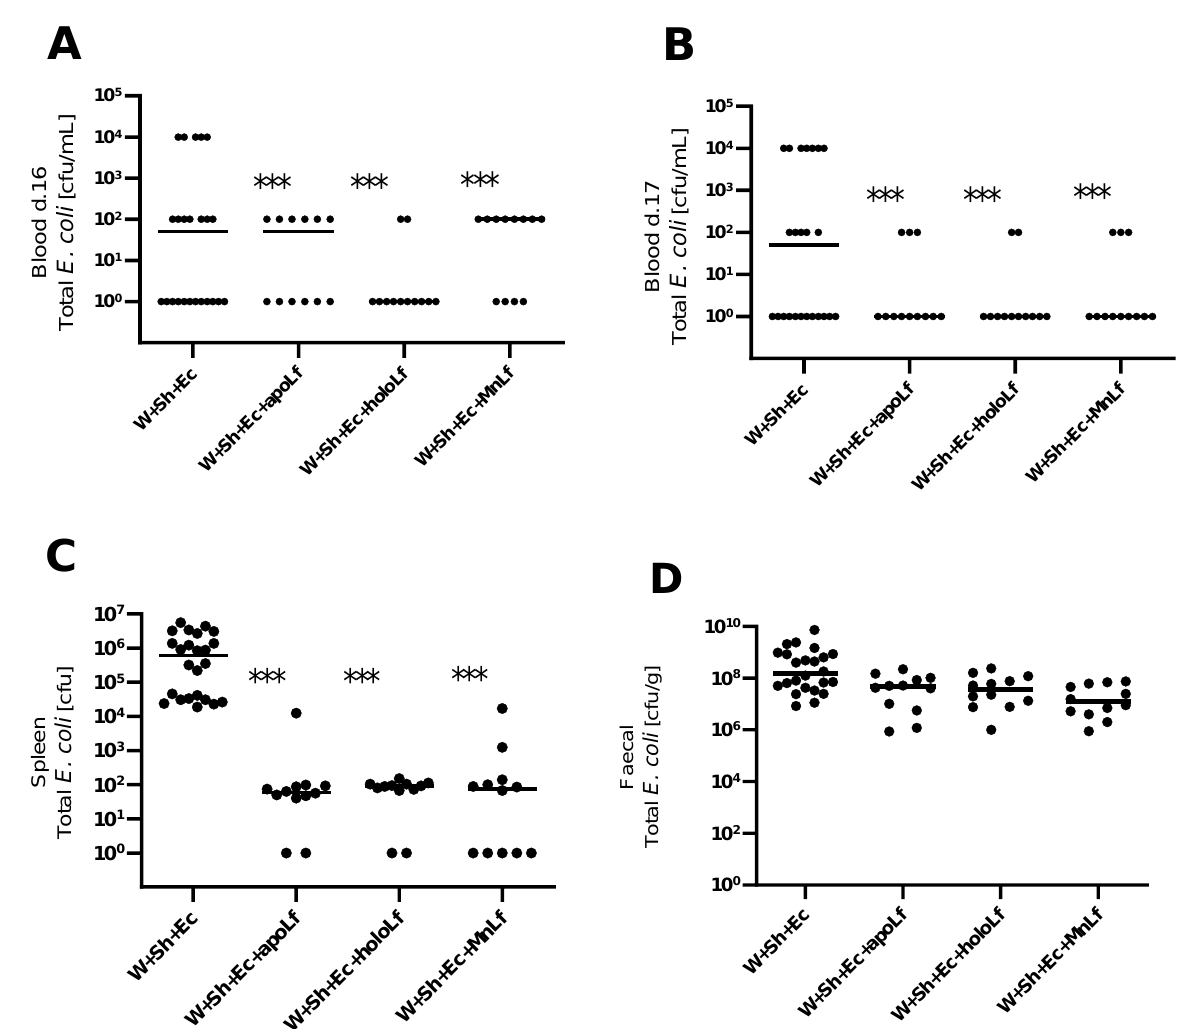
Figure 4. Population numbers of total E. coli for groups with lactoferrin supplementation in blood d. 16 ( A ), blood d. 17 ( B ), spleen ( C ) and feces ( D ). *** p < 0.01 vs. W+Sh+Ec group. W+Sh+Ec-target model group weaned with administration of both intraperitoneal S. haemolyticus 186 and oral E. coli 3A/1. W+Sh+Ec+apoLf-p.o. metal-depleted apoLf, W+Sh+Ec+holoLf-p.o. iron-saturated holoLf, W+Sh+Ec+MnLf-p.o. manganese-saturated MnLf.